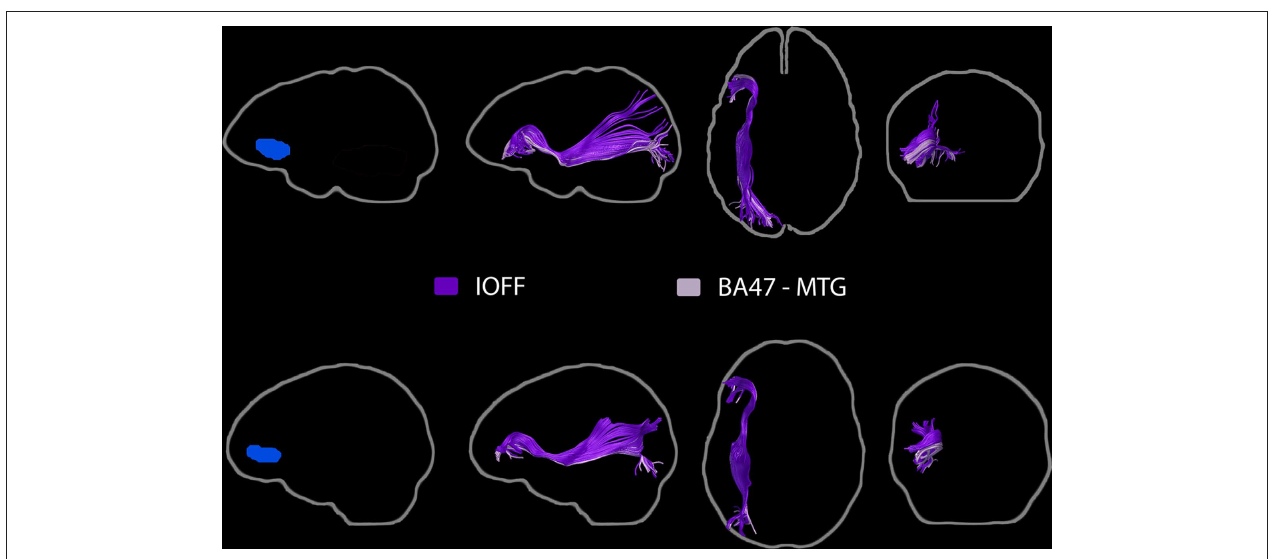
Figure 8 | Pathways associated with the BA47 rOi (left, blue). Streamline tractography results from two subjects are presented as exemplars. The inferior occipito-frontal fasciculus as well as a group of IOFF fibers associated with the posterior MTG ROI were